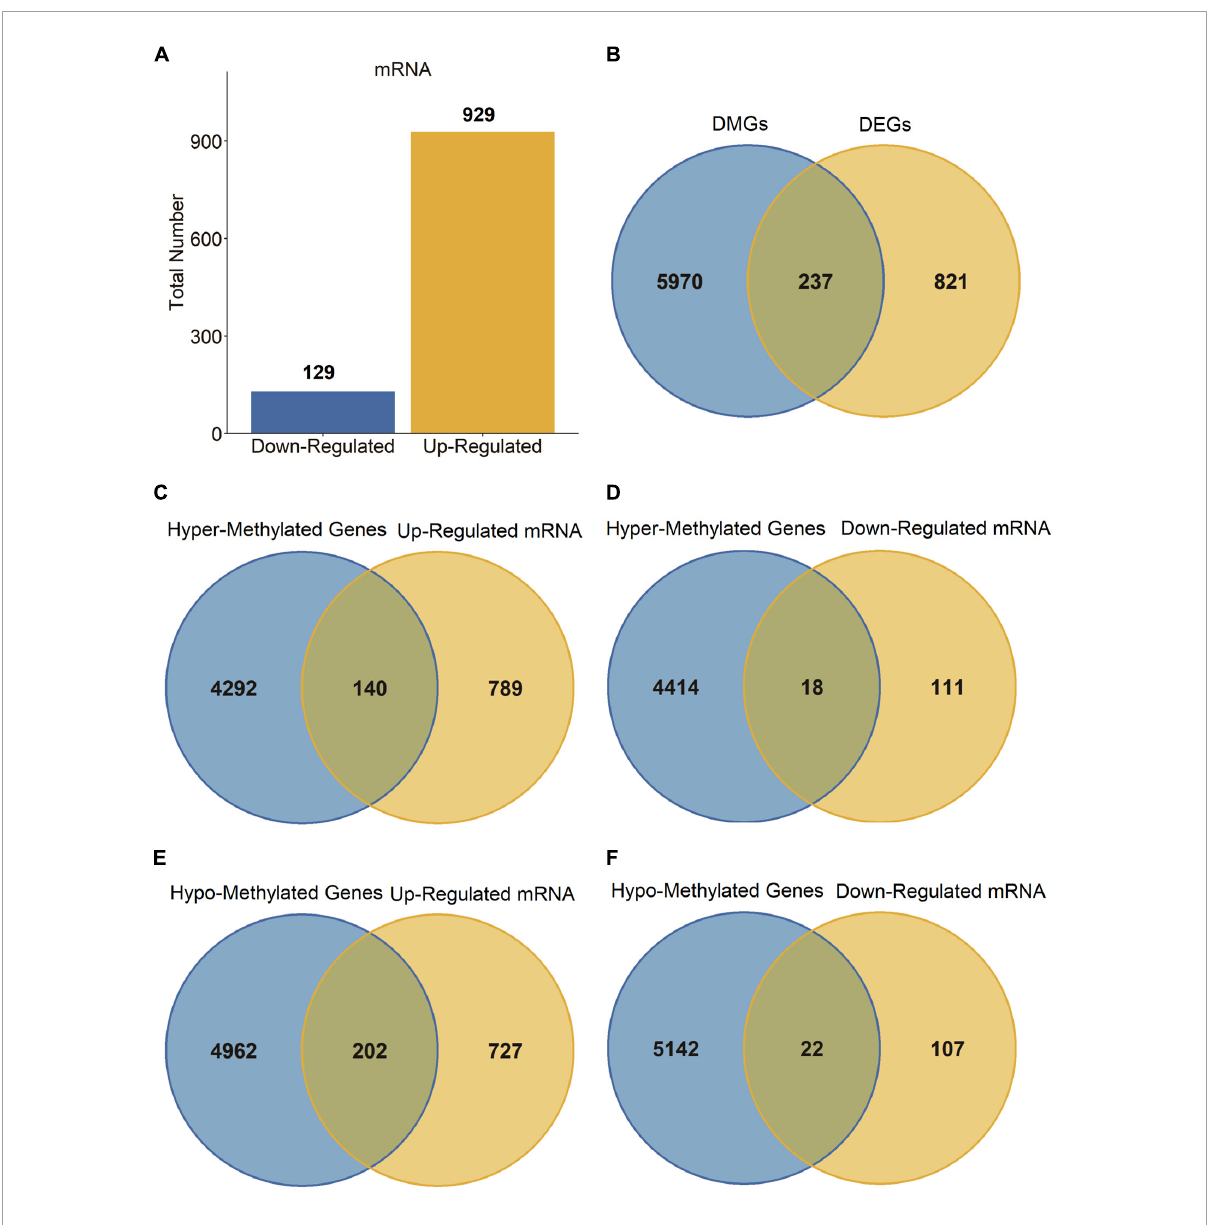
FIGURE2 DEGs in PD patients. (A) Bar plot for DEGs in PD patients and healthy controls. (B–F) Venn diagram of DMGs and